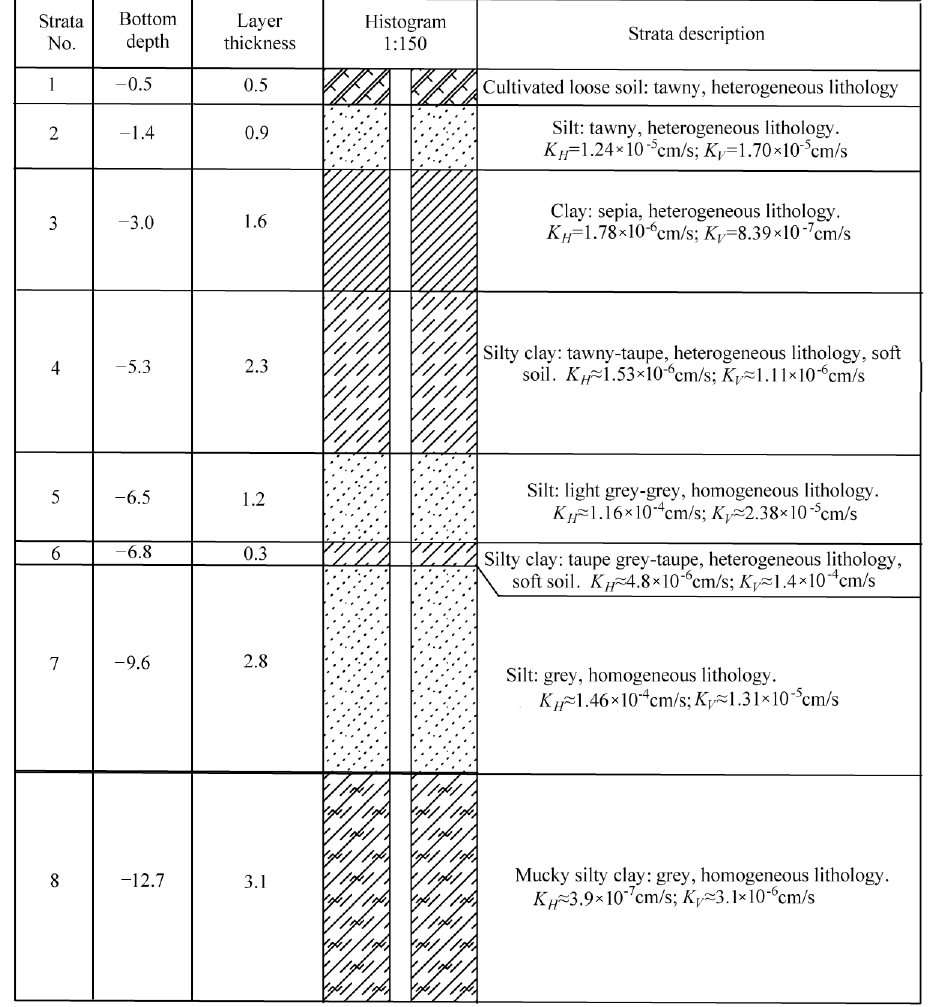
Figure 3. Schematic diagram of strata distribution in the study site.